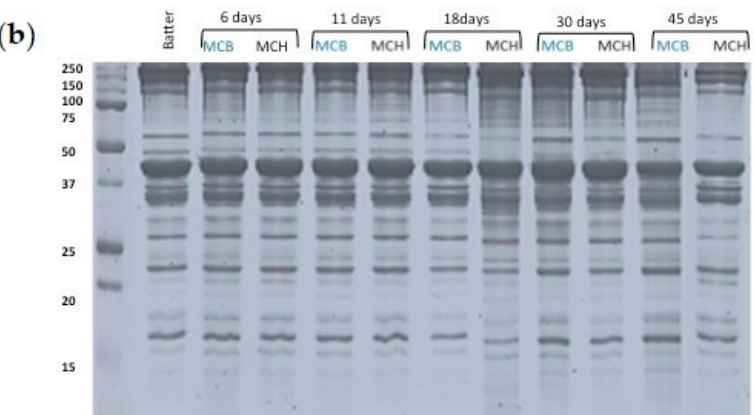
Figure 2. SDS-PAGE electrophoretic profiles of “ Mortadella di Campotosto ”-like sausages produced with beef (MCB) and hog (MCH) casings over time. Panel ( a ) sarcoplasmic fraction; panel ( b ) myofibrillar fraction. Batter: 0 days. Values on the ordinates refer to the marker and express the bands dimension in KDa.